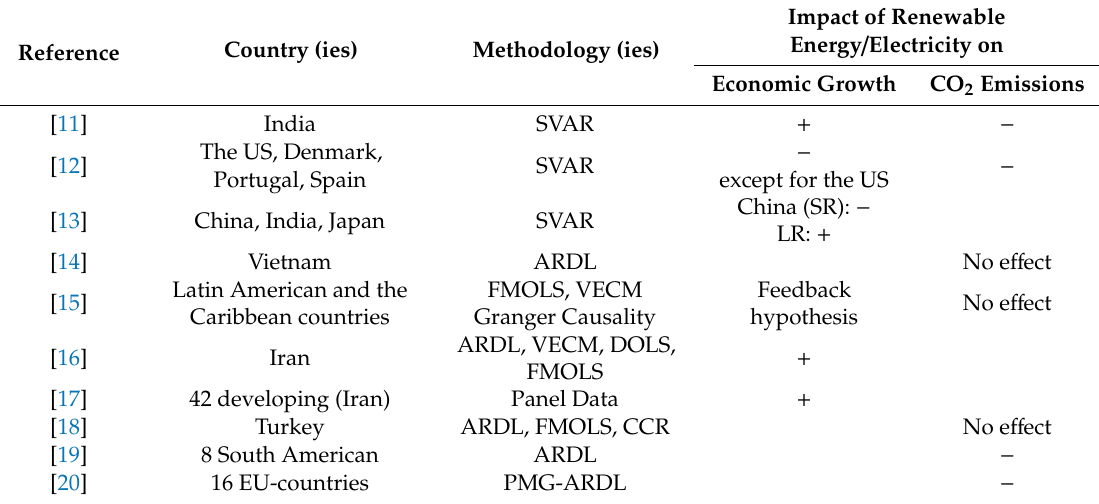
Table 1. Summary of empirical